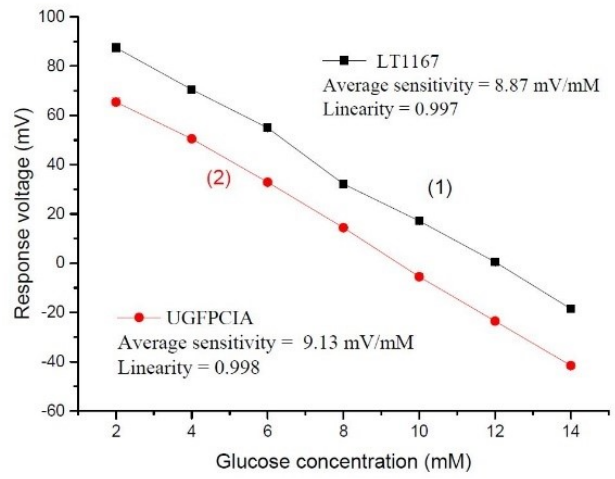
Figure 4. Average sensitivities of the AgNWs/CZO sensor. Table 1. The standard deviations of the different glucose sensors.